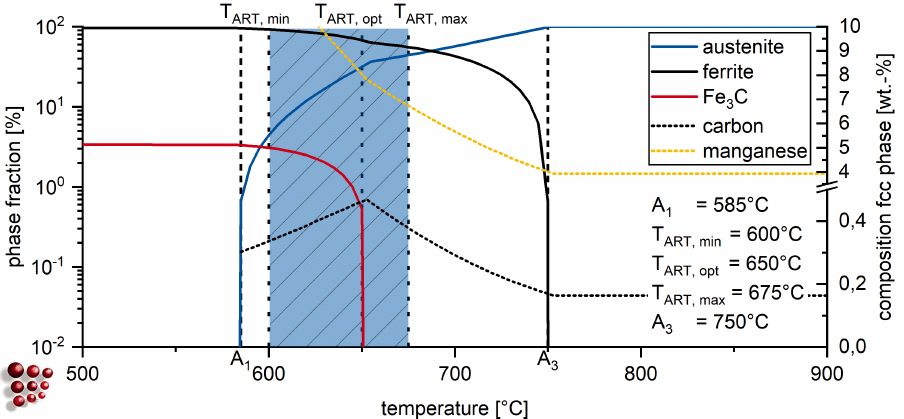
Figure 2. Thermodynamic equilibrium calculations of the temperature dependency of the different phases and the equilibrium C and Mn contents of the fcc phase. The investigated temperature range for ART annealing is